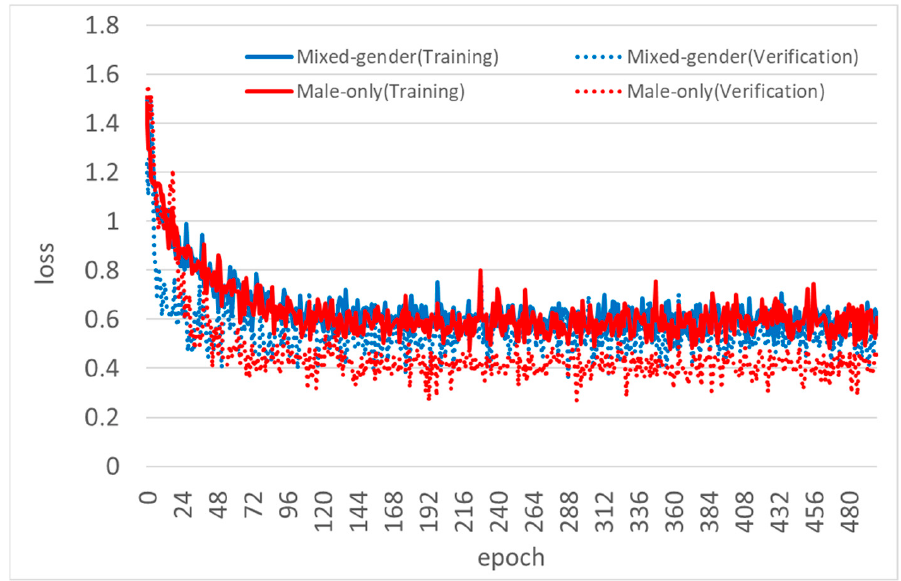
Figure 6. Progress of learning training and validation data (loss). Table 8. Confusion matrix using test data